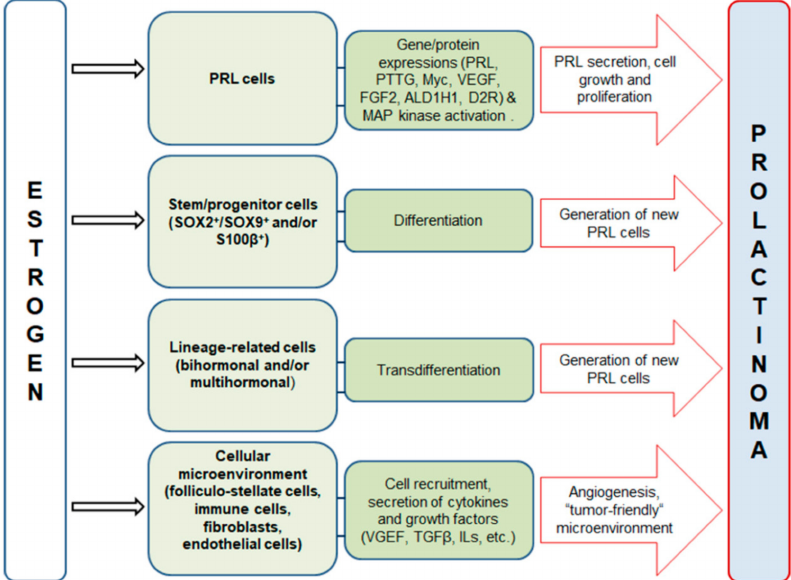
Figure 1. Proposed cellular and molecular targets of estrogen treatment action that contribute to pituitary lactotropic (PRL) cell hyperplasia, hyperprolactinemia and prolactinoma development. Estrogen may a ff ect already-di ff erentiated PRL cells, stem / progenitor cells, lineage-related cells and cells comprisingthemicroenvironment. Transcriptionalregulationofthefollowinggenesismainlyassociated with tumorigenic action of estrogen in the pituitary: pituitary tumor transforming gene (PTTG); Myc; aldehyde dehydrogenase 1A1 (ALDH1A1); D2R, dopamine D2 receptor; mitogen-activated protein kinases (MAPK); vascular endothelial growth factor (VEGF); fibroblast growth factor 2 (FGF2); transforming growth factor β (TGF β ) and other growth factors and cytokines, such as ILs, interleukines